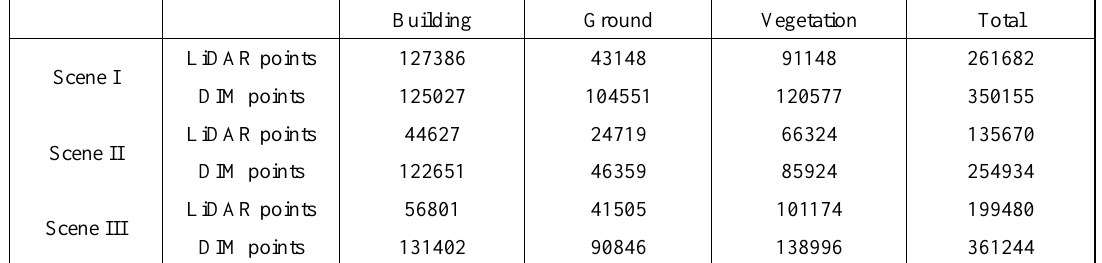
Table 1. The number of the two kinds of point clouds of each class in each scene